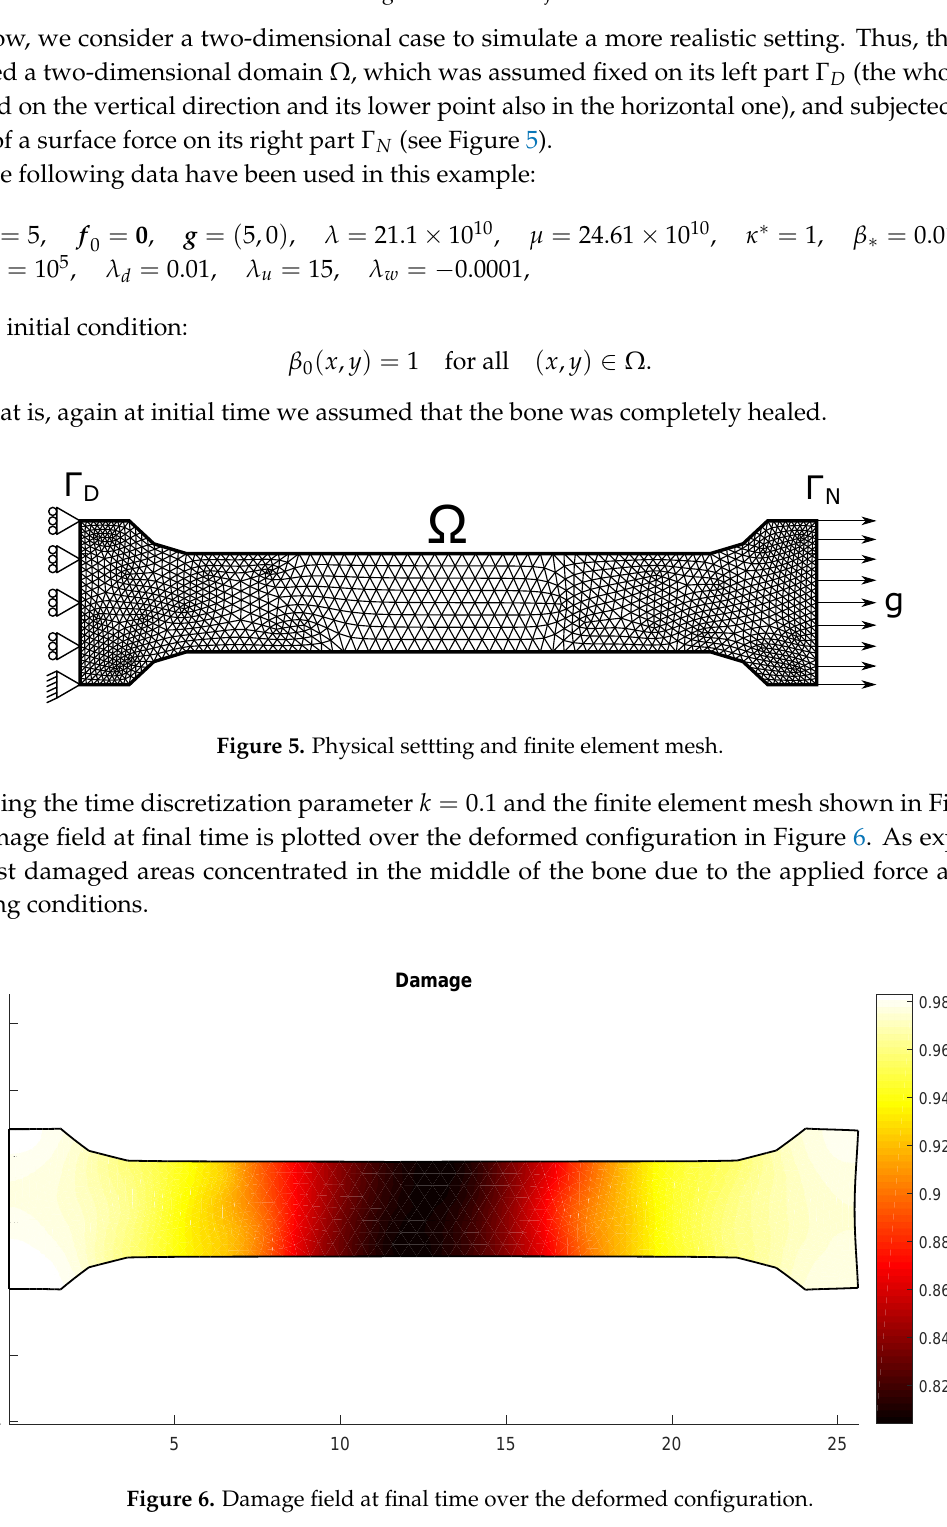
Figure 7. von Mises stress norm at final time over the deformed configuration. Moreover, a two-dimensional example was also considered using the Frémond-Nedjar model to show 182 the behaviour of its solution in a more real situation. The advantage of the use of the Frémond-Nedjar 183